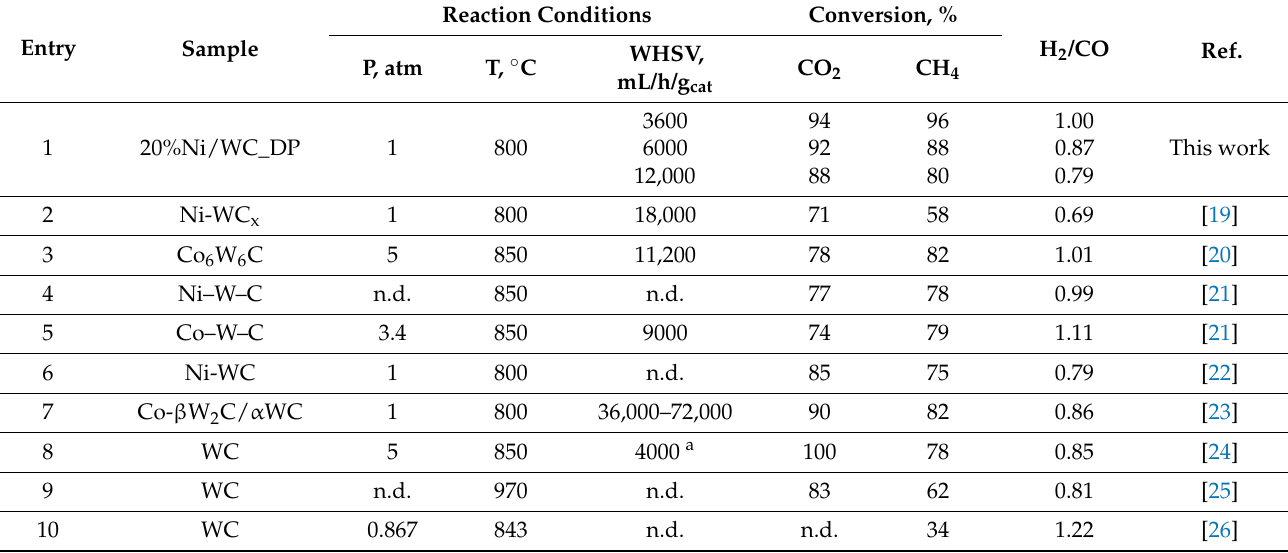
Table 2. Ni-WC, Co-WC and WC catalysts used in